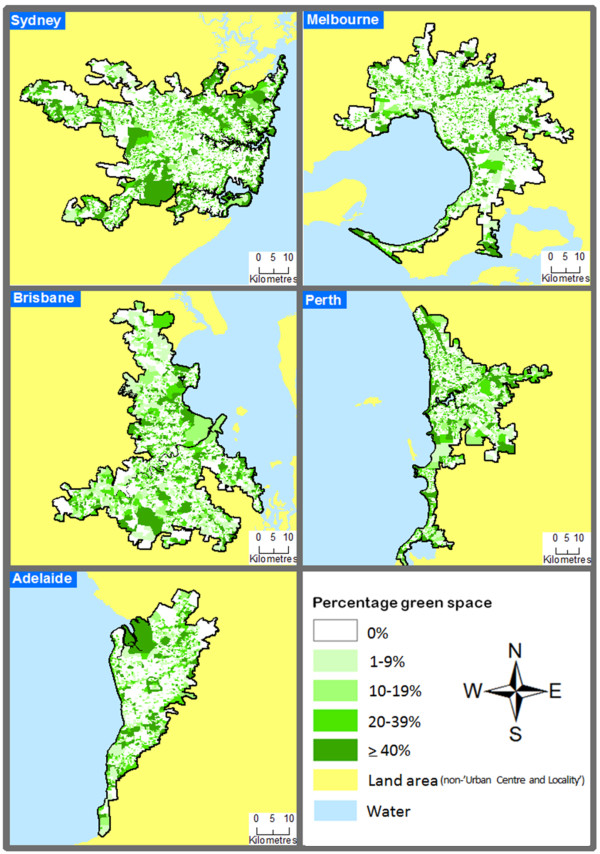
Spatial patterning of green space in Australia’s most populous cities.